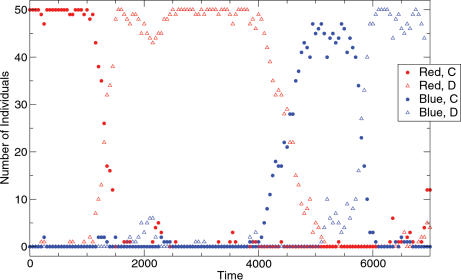
Evolutionary chromodynamics in finite populations. The red cooperator population is invaded by red defectors at t≈1200. At t≈4500, cooperation is established based on blue tags. Blue defectors invade at t≈6000. The time unit is given by one individual learning event (pairwise comparison). For example, after t = 5000 each individual had 100 learning events on average. The following parameters are used: population size N = 50, intensity of selection β = 1.0, cost of cooperation c = 0.5, benefit from cooperation b = 1.0, mutation rate u = 0.01.